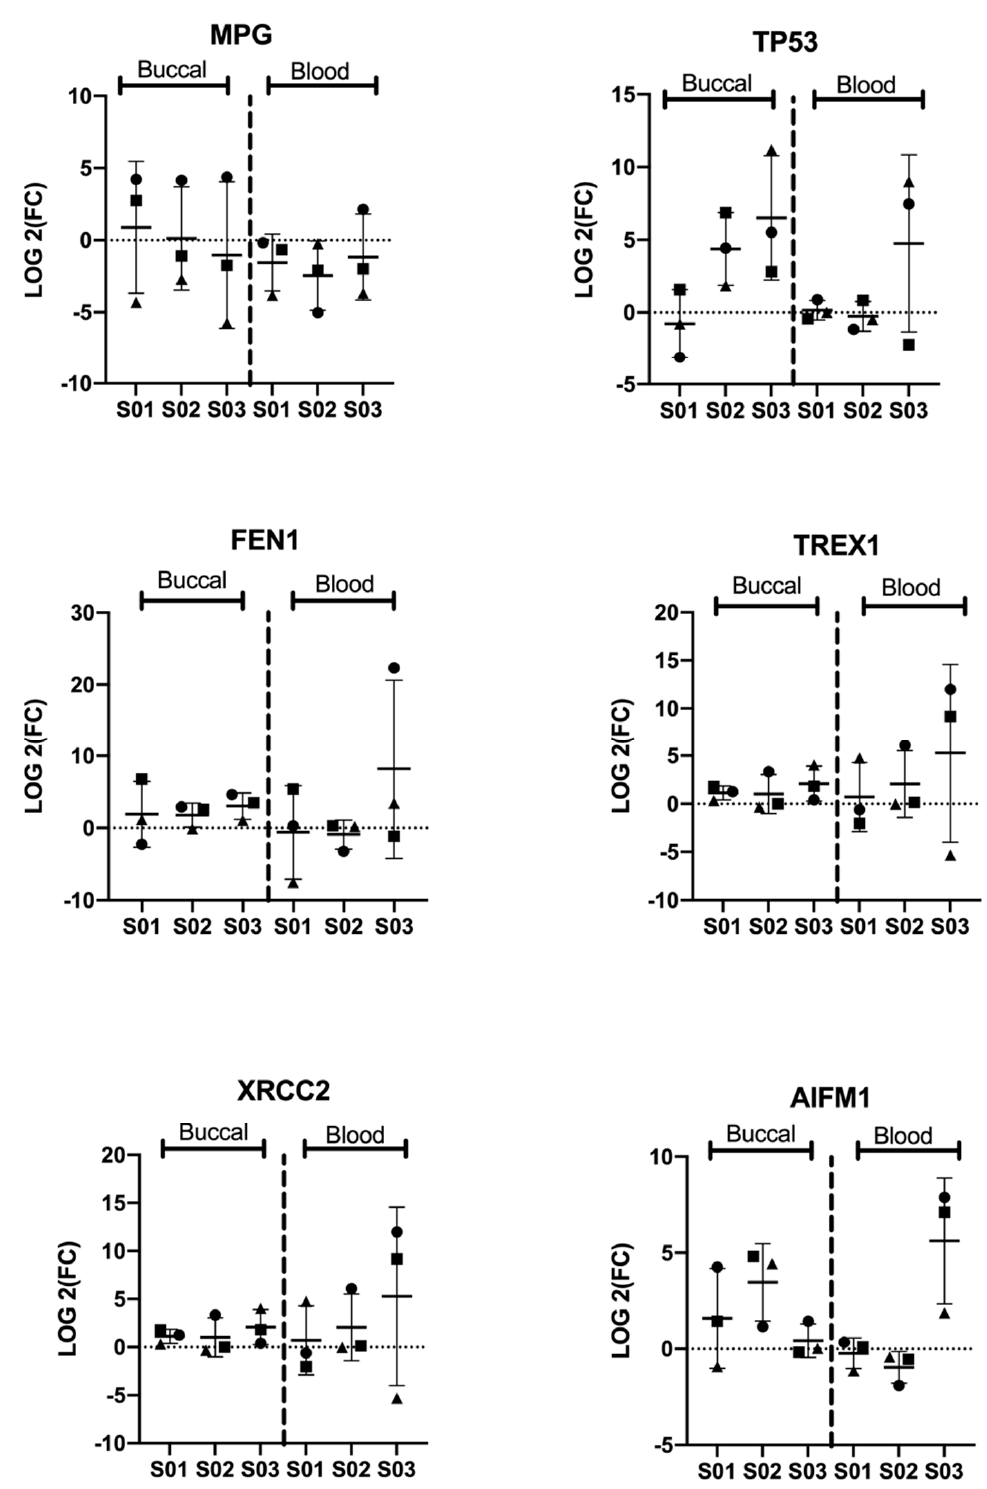
Figure 4. Log2 fold change (FC) of the significantly ( p < 0.05) and differentially (1.5-fold change up or down) regulated genes in buccal and blood samples across the three visits (V1-V3; n TOT = 9). Triangle refers to visit 1; square to visit 2; and ball to visit 3. N-methylpurine DNA glycosylase ( MPG ) was significantly downregulated in blood samples; other genes, including tumor suppressor TP53 , were significantly upregulated in buccal epithelial samples.